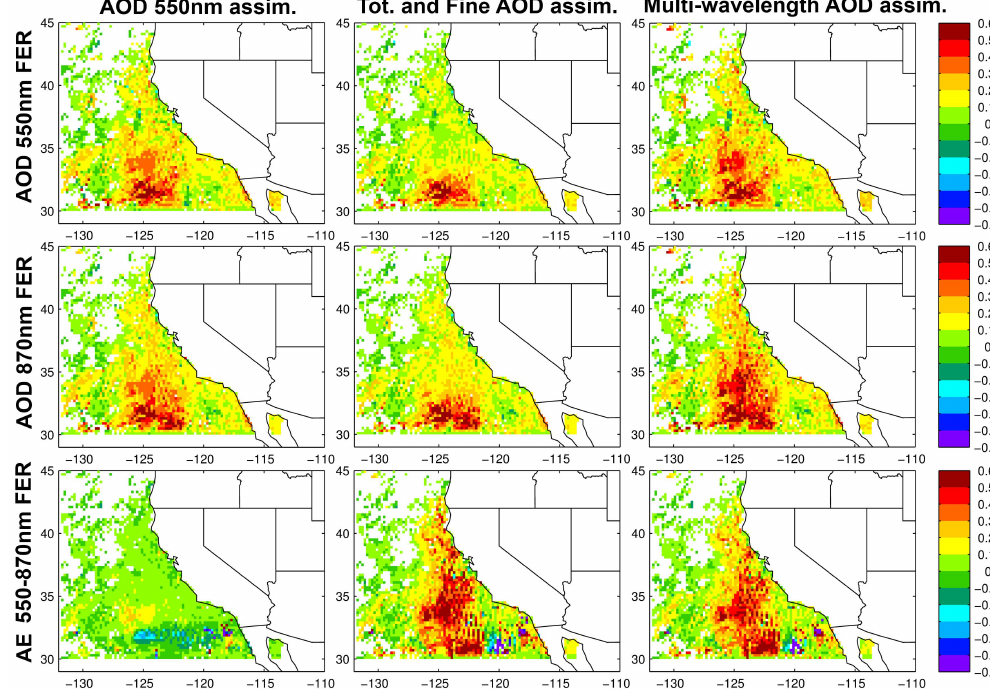
Fig. 11. Fractional error reductions for 550nm AOD, 870nm AOD and 550–870nm Ångström exponent (rows) from non-assimilated to assimilated model computed with respect to Aqua retrievals. Figures in the left column assimilate only MODIS 550nm AOD (control), in the center column assimilate both total and fine AOD at 550nm, while the ones in the right column assimilate MODIS 550, 660, 870, and 1240nm over ocean and only 550nm over land. As described in Fig. 10, these figures correspond to a fractional error reduction for a 3h forecast for May